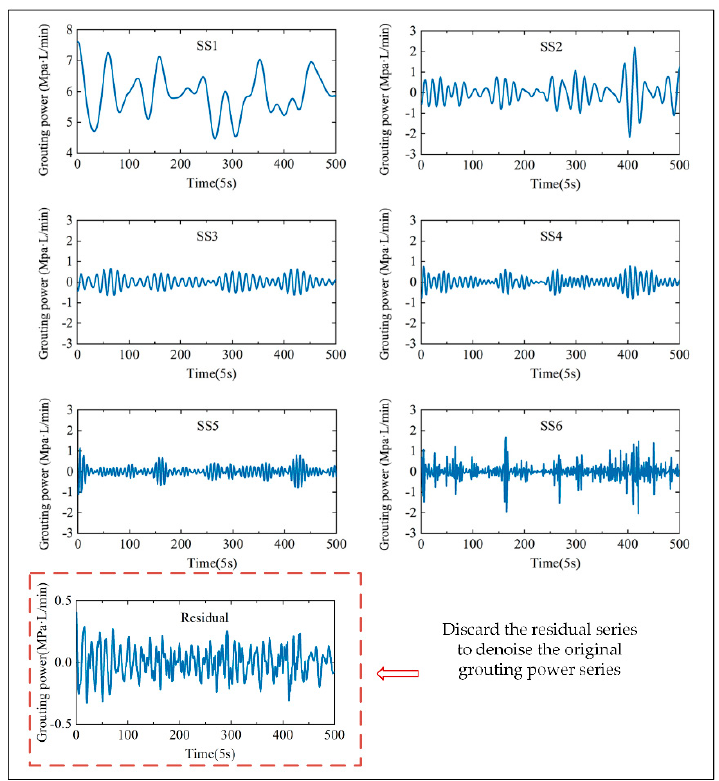
Figure 5. The decomposed subseries and residual series of the grouting power by EWT.